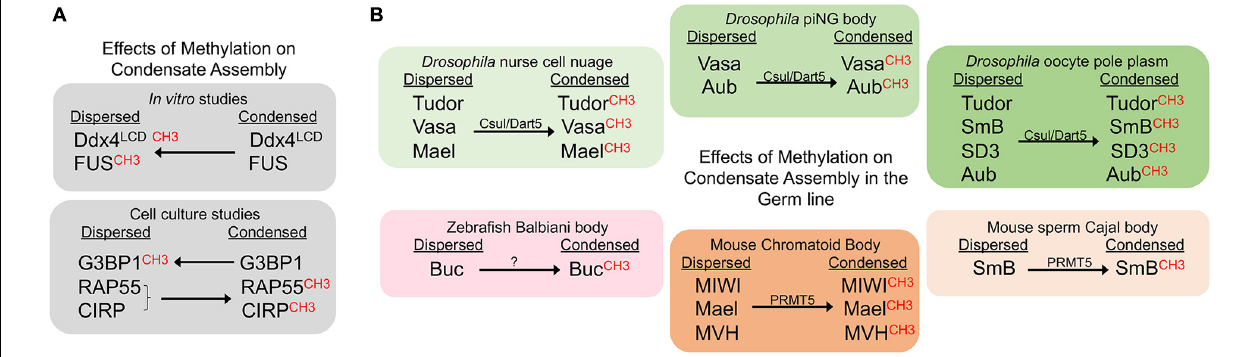
FIGURE 1 | Methylation promotes condensate assembly in the germ line. CH3 indicates the methylated form of the corresponding protein. Arrows indicate whether methylation promotes or inhibits a condensed state. (A) Methylation suppresses condensates in in vitro studies, but can sometimes promote condensation in cell culture. (B) Methylation promotes condensation of germ line proteins. Effects of methylation are shown for six distinct germ line RNP granules in three model